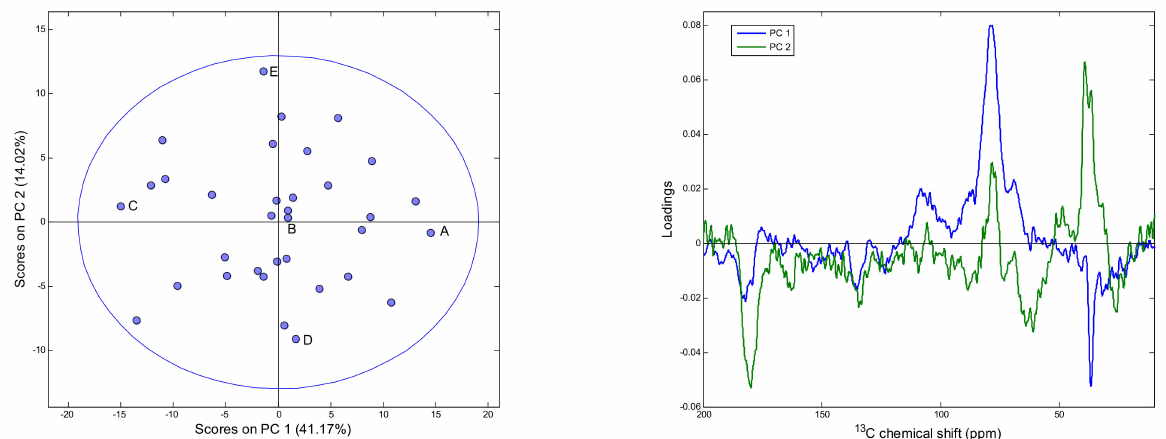
Figure 3. PC1/PC2 scores ( left ) and plot of the first two PCA loadings ( right